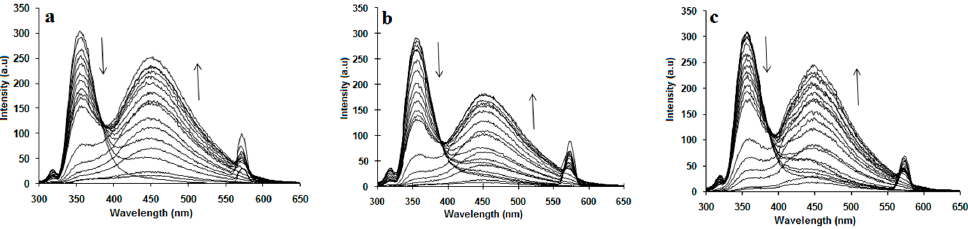
Figure 2. Change in fluorescence spectra of NAP at λ max = 357 nm and of ( a ) 1a , ( b ) 1b , ( c ) 1c at λ max = 450 nm with the concentration of added 1a – c .